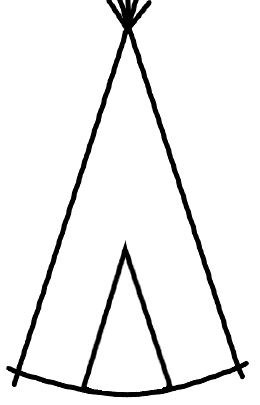
Figure 3. Illustration of a tipi.